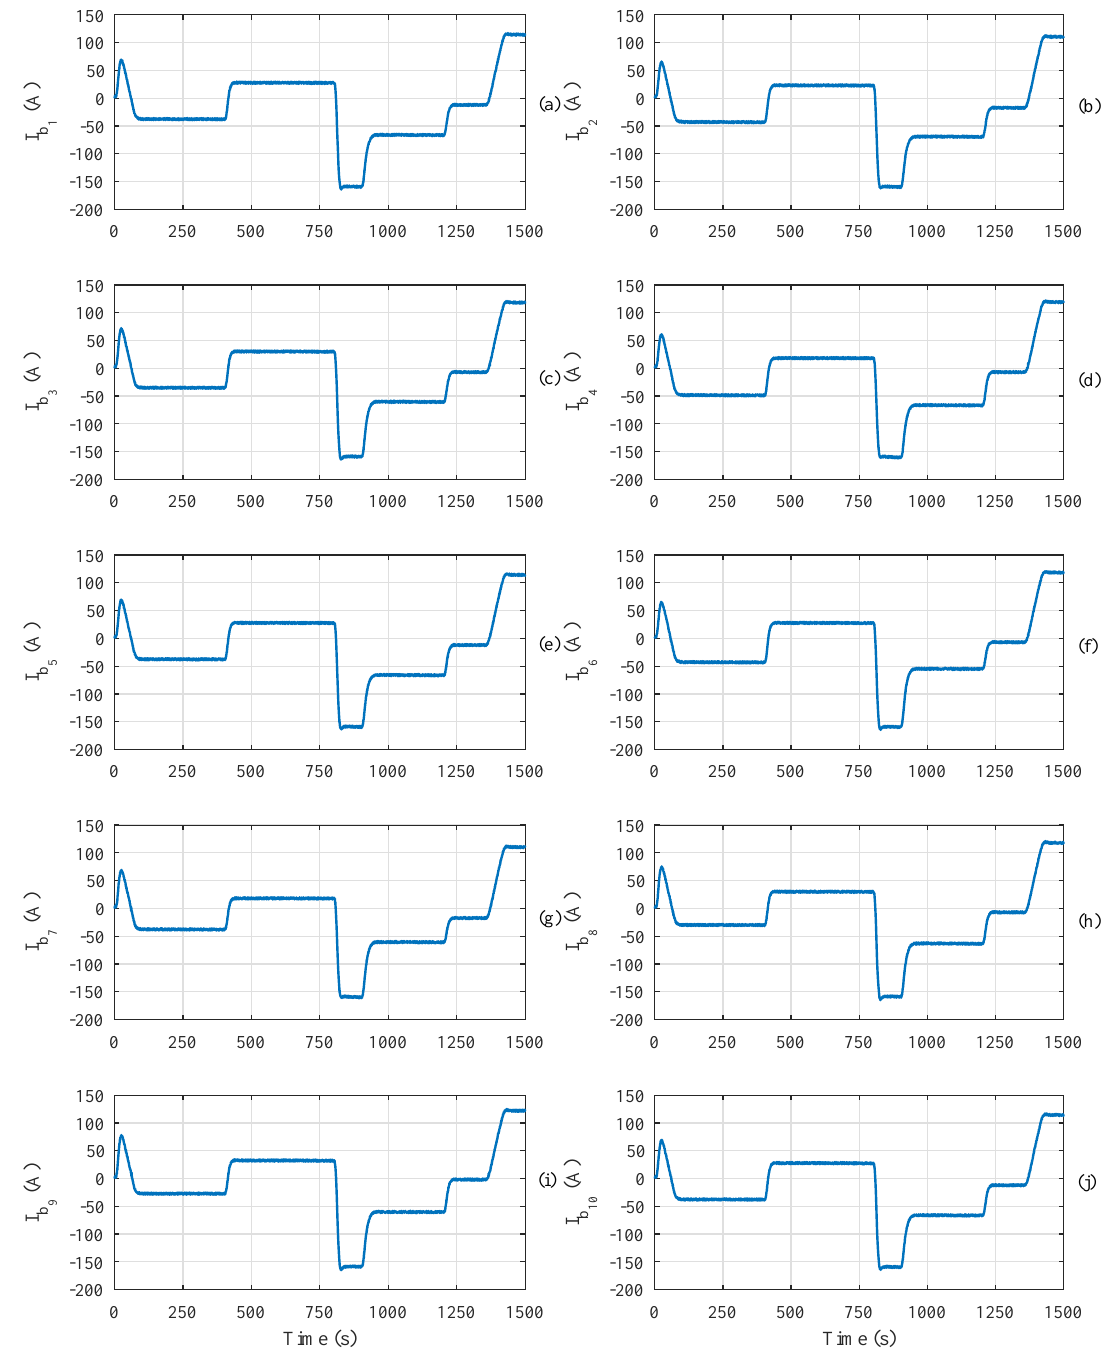
Figure 21. Currents through the banks of batteries of the 10 hybrid energy storage systems (HESSs). ( a ) i b ; ( b ) i b ; ( c ) i b ; ( d ) i b ; ( e ) i b ; ( f ) i b ; ( g ) i b ; ( h ) i b ; ( i ) i b ; and ( j ) i b 2 3 5 6 7 8 9 1 4